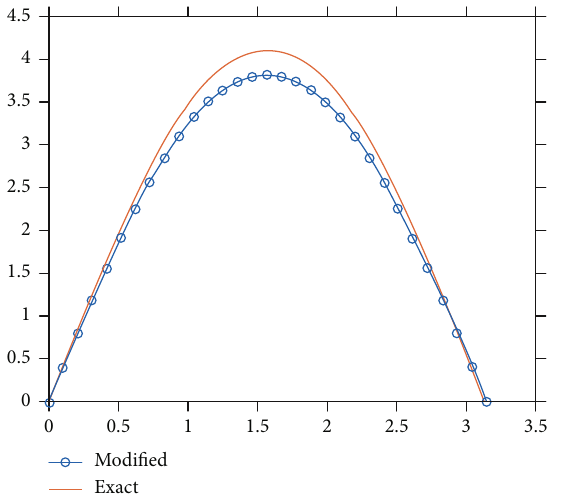
Figure 9: The variations of the system of equation (35) and the solution of the regularized system of equations (12) – (15) for p = 1 , k = 0 : 5 , α = 0 : 03 , and y = 1 .